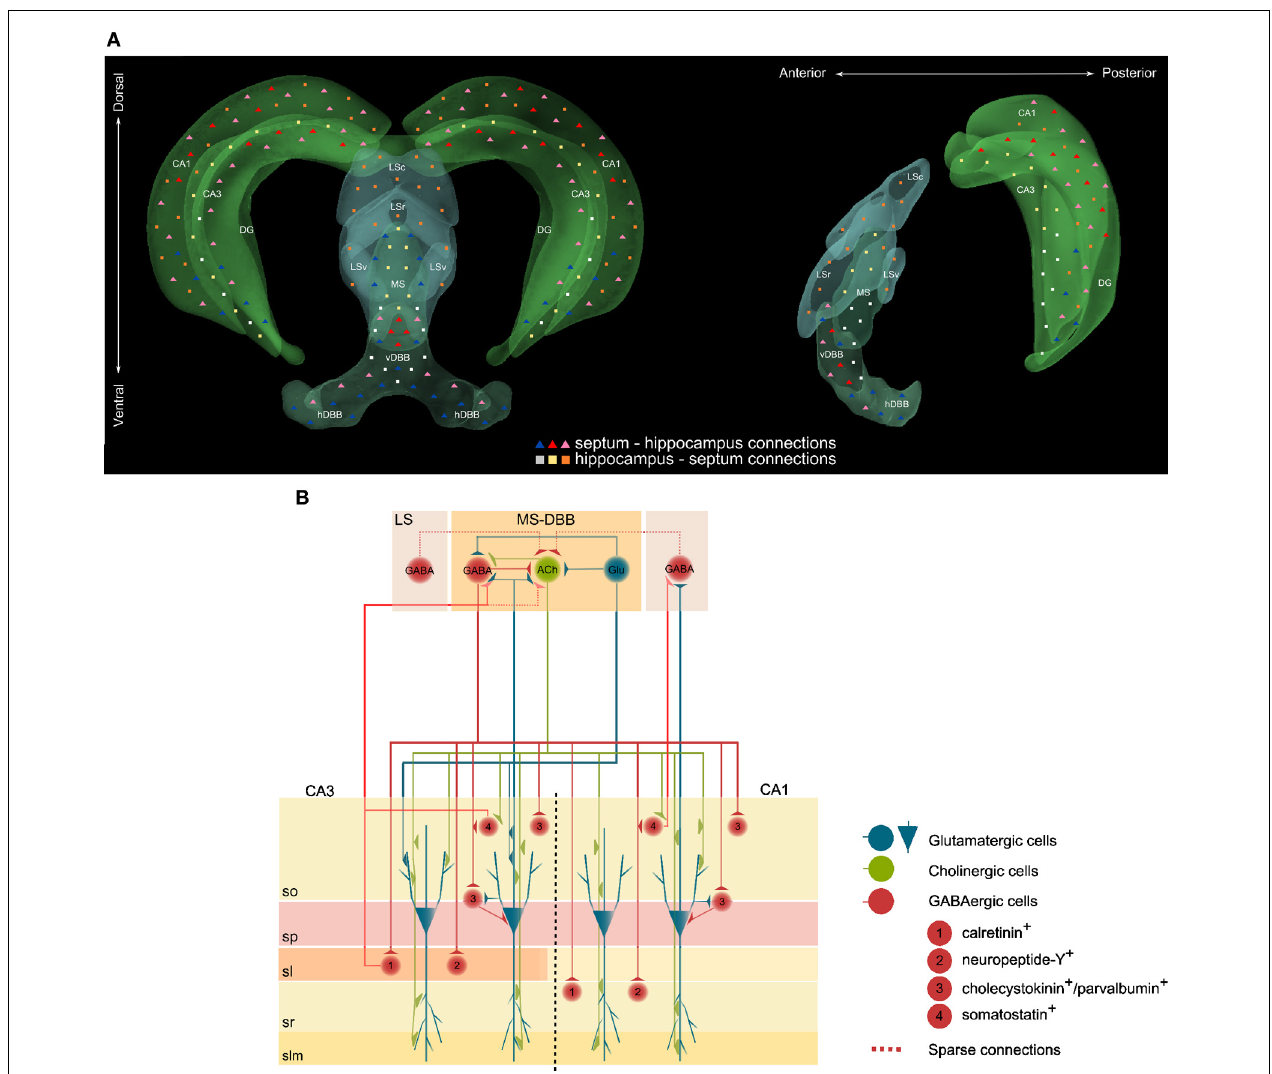
FIGURE 1 | (A) Schematic representation of the reciprocal connections between the septum and the hippocampus. In the coronal (left) and saggital (right) views, triangles represent connections from the septum to the hippocampus and squares represent connections from the hippocampus to the septum. Color-code specifies sub-regions where cell bodies are located and where axonal projections terminate. Abbreviations: LSc, lateral septum caudal; LSr, lateral septum rostral; LSv, lateral septum